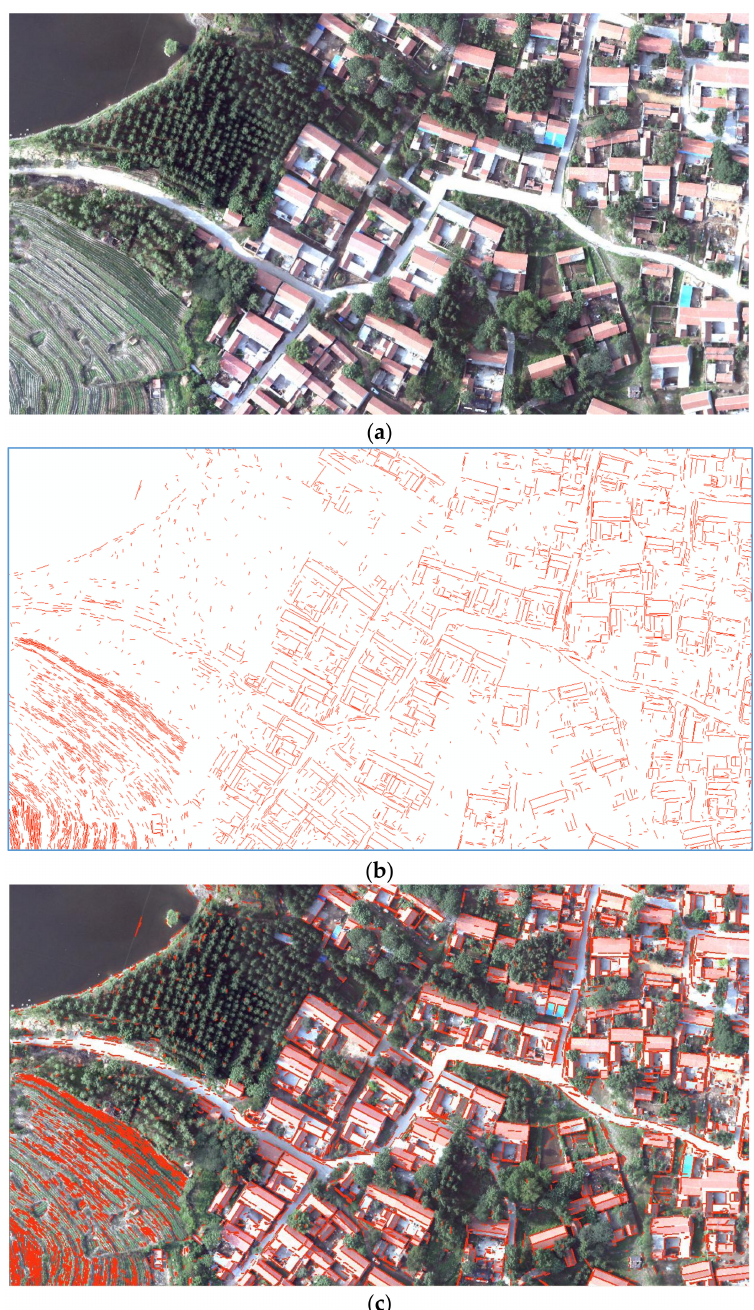
Figure 2. The extraction of line segments by the Line Segment Detector. ( a ) A subset of a VHSR satellite image; ( b ) the detected line segments (marked with red color) and ( c ) the detected line segments (marked with red color) imposed on the original